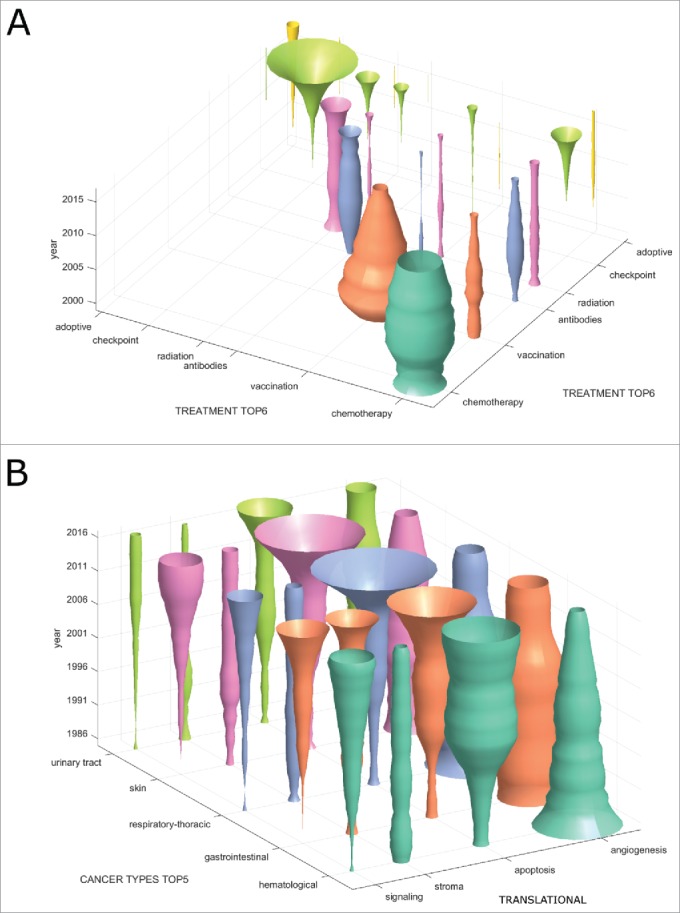
Emerging immunotherapy paradigms. (A) Co-occurrence of cancer immunotherapy treatment approaches in clinical trials between 2000 and 2017. On the diagonal, the development of individual treatment approaches is shown with checkpoint inhibition displaying a rapid increase. Off the diagonal, treatment combinations are shown with chemotherapy and checkpoint inhibition being the most common and rapidly growing combination. (B) This bivariate plot shows cancer immunotherapy trends grouped by translational research topics and major cancer types based on all PubMed publications between 1986 and 2017. Among signalling, stroma, apoptosis and angiogenesis, apoptosis is the most rapidly growing topic in all major cancer entities except hematological neoplasms. Stroma and signalling are most rapidly increasing in gastrointestinal cancer.